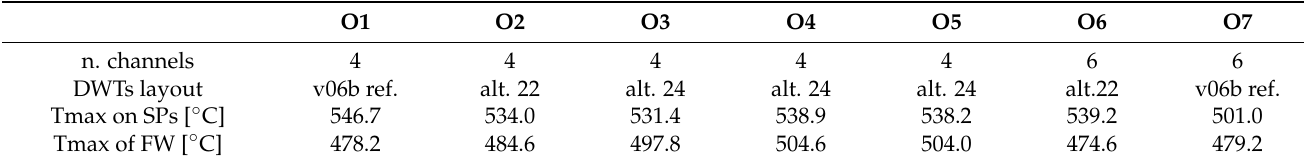
Table 4. BZ and FW-SW cooling layout per poloidal